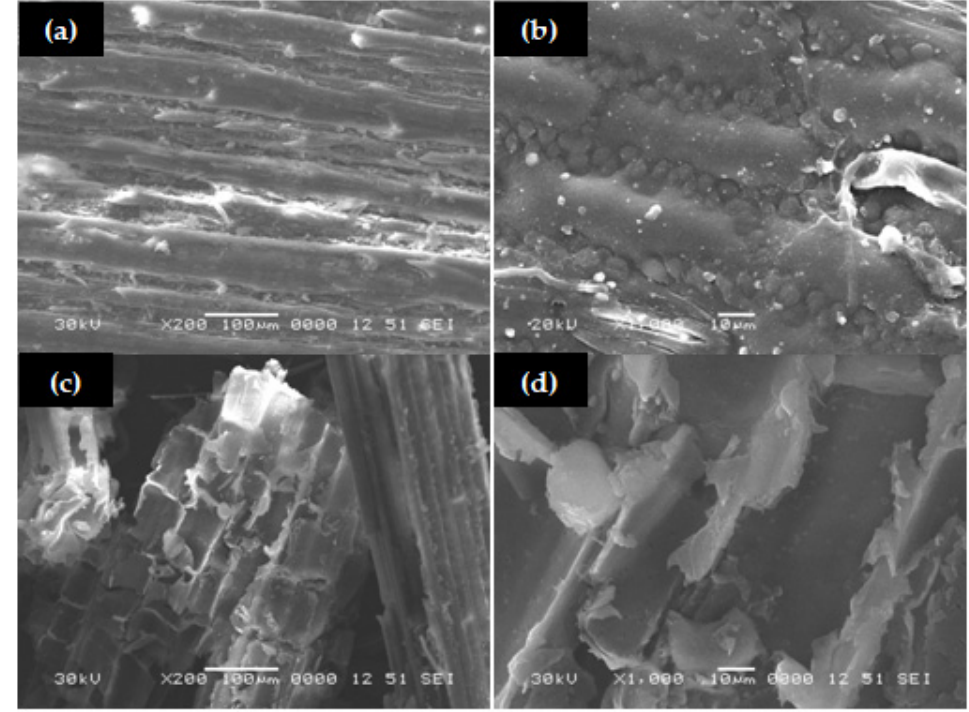
Figure 6. SEM images of ( a , b ) CS and ( c , d ) CSM.